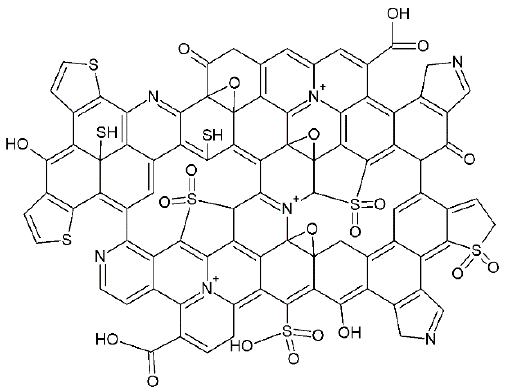
Scheme 1. Structure of nitrogen and sulfur functionalized reduced graphene